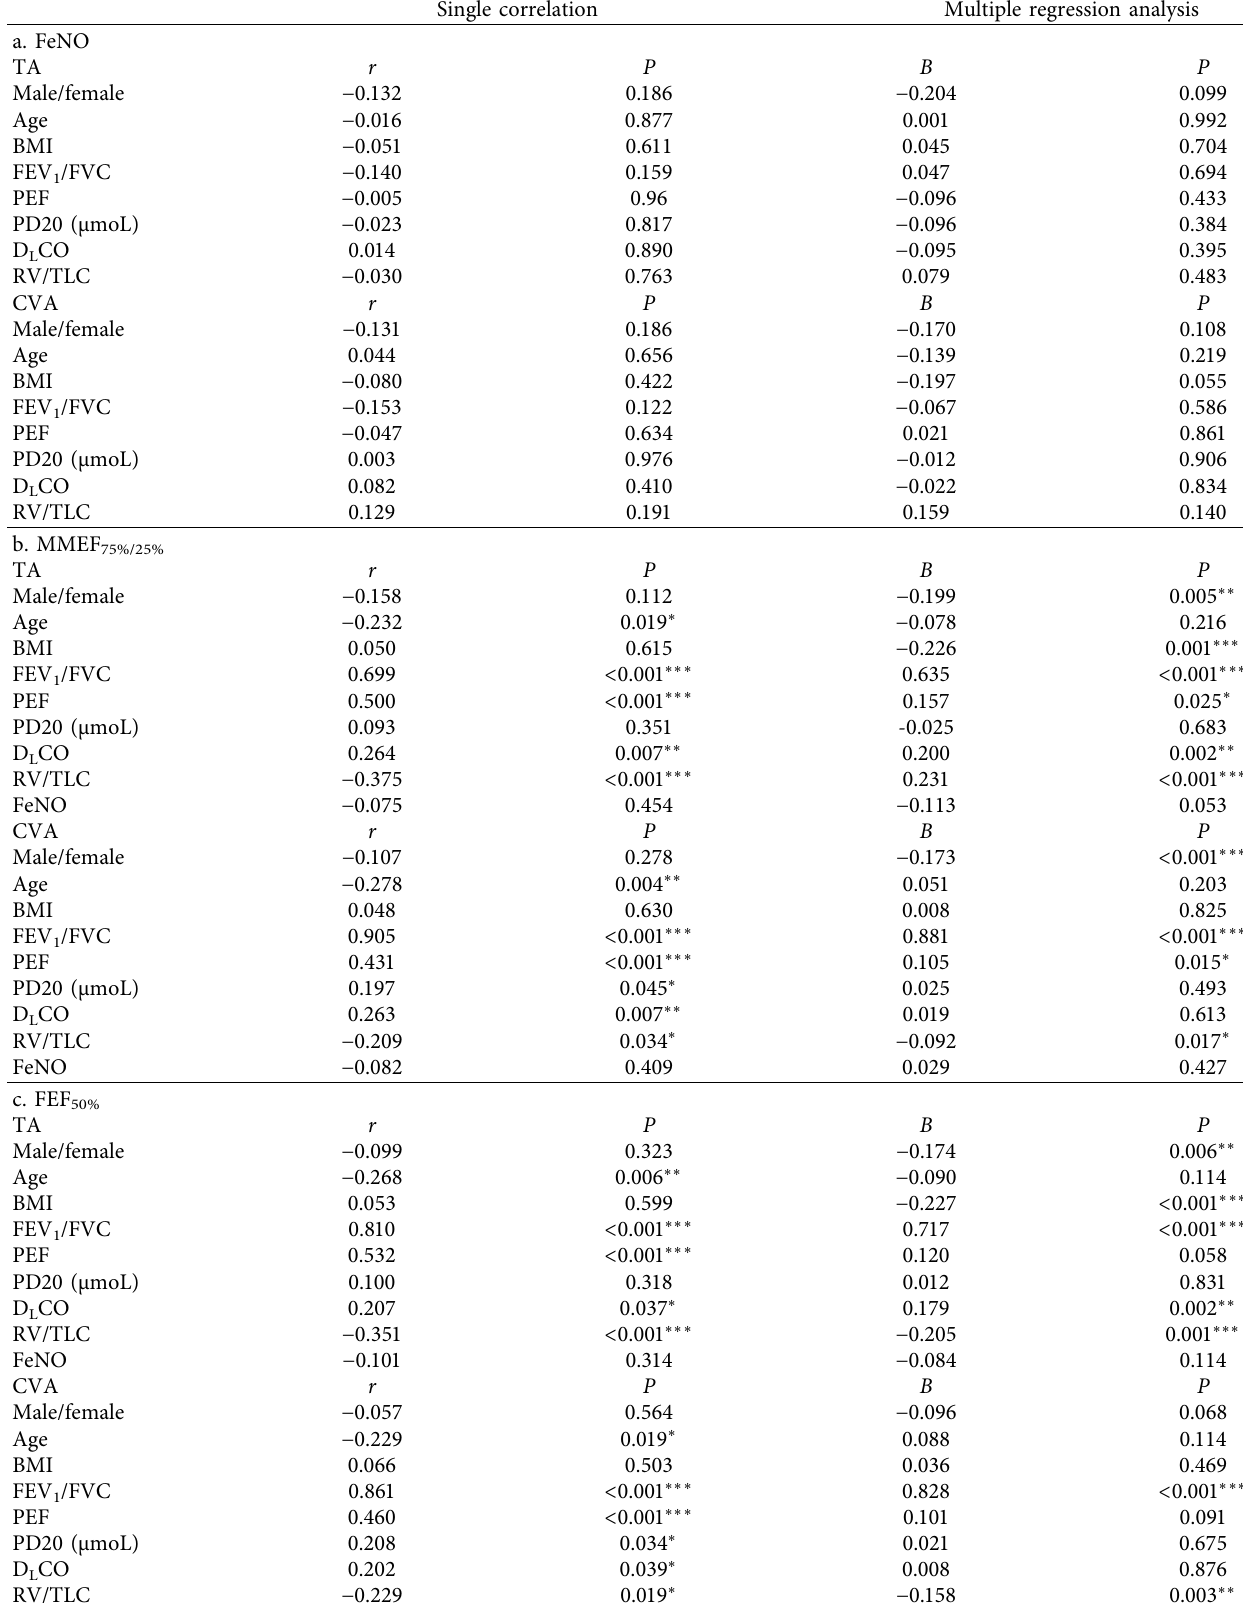
Table 3: Correlations between FeNO or small airways function and other